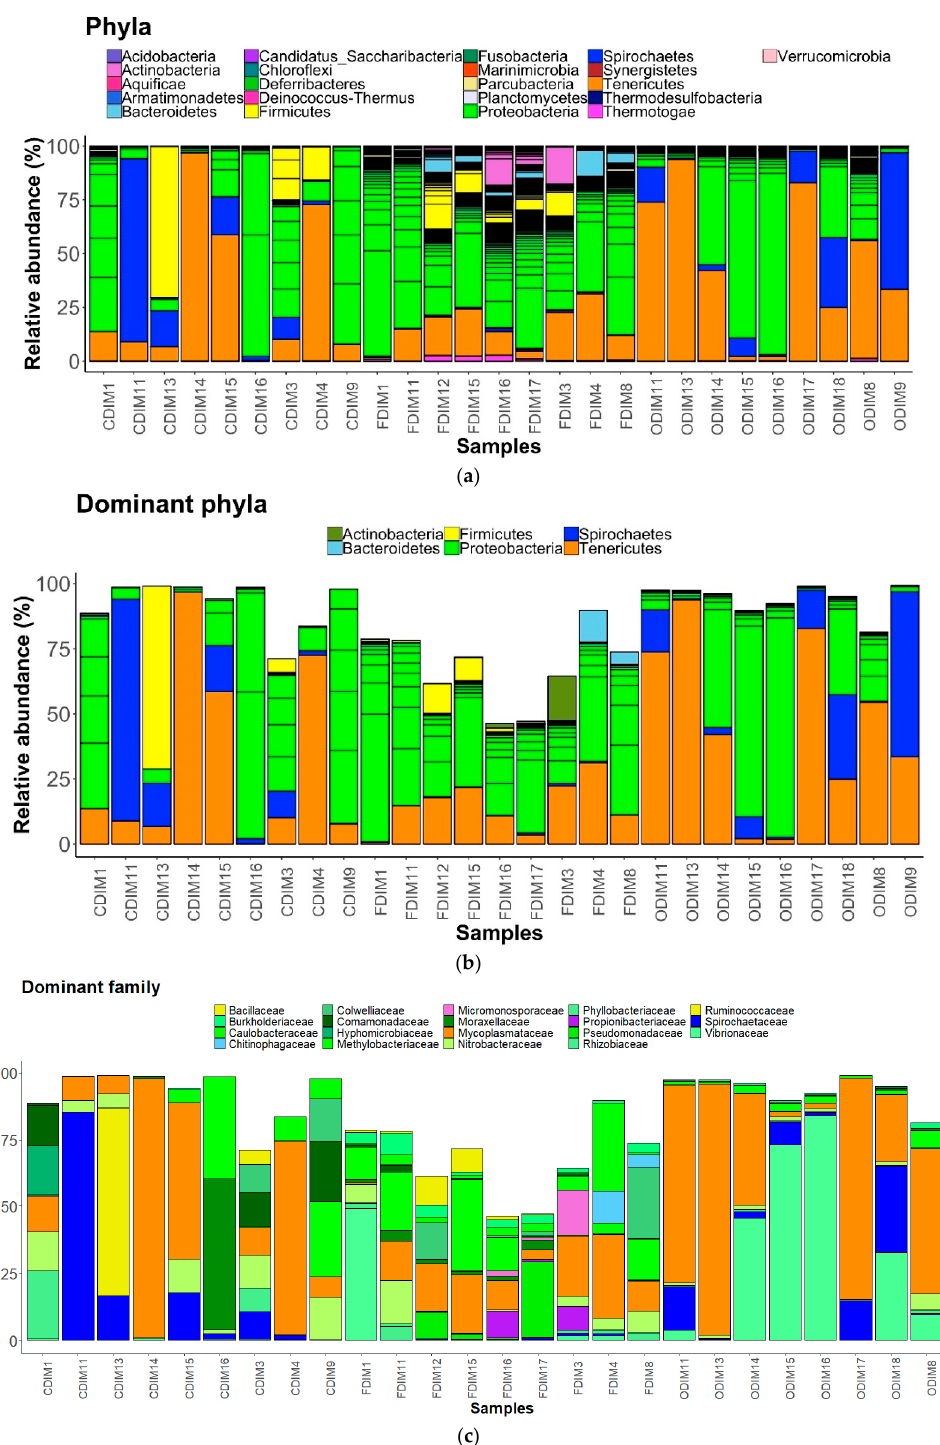
Figure 3. The relative abundance of the bacterial taxa present in the distal intestine mucus of Atlantic salmon. All the bacterial phyla ( a ), dominant phyla ( b ), and dominant families ( c ). Color codes for Proteobacteria—Shades of green, Spirochaetes—Dark blue, Firmicutes—Yellow, Actinobacteria—Orchid, and Tenericutes—Dark orange. The samples with C prefixes come from the control group. Similarly, those with F and O show the florfenicol- and oxolinic-acid-fed groups, respectively.